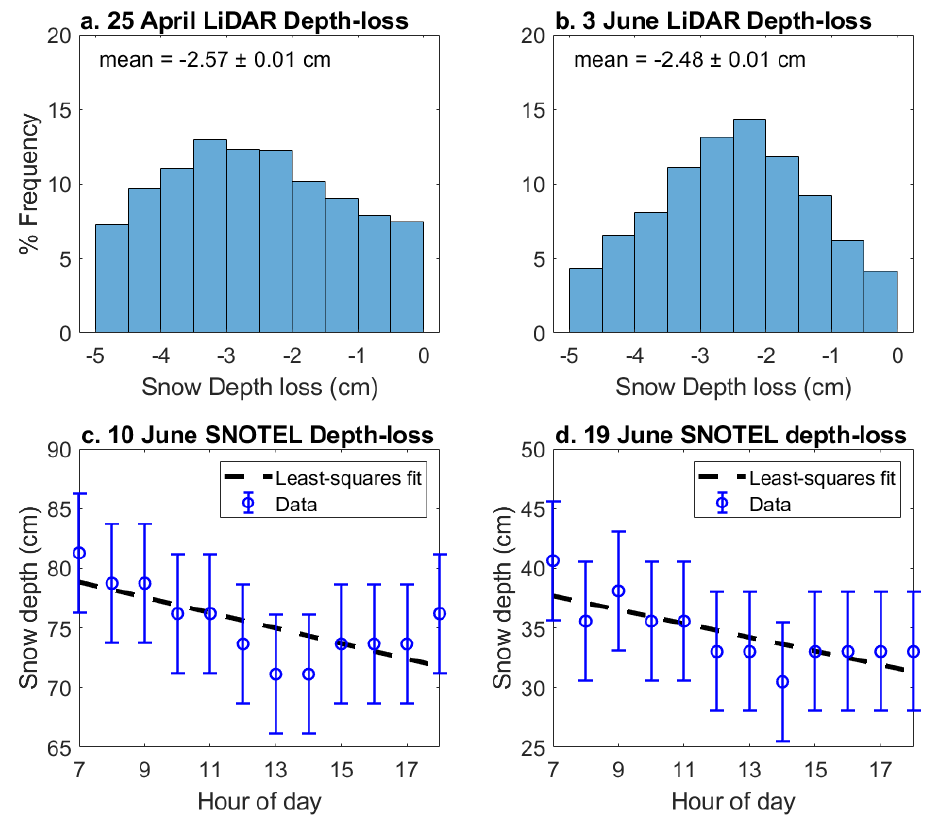
Figure 6. ( a ) Snow depth loss histogram for 25 April TLS morning (10:00–11:00 MDT) and midday (14:00–15:00 MDT) surveys. ( b ) Snow depth loss histogram for 3 June TLS morning and midday surveys. 95% confidence interval calculated using t-distribution. ( c ) 10 June least-squares regression analysis for snow depth loss plotted with SNOTEL measured depths with 5 cm uncertainty. ( d ) 19 June least-squares regression analysis for snow depth loss plotted with SNOTEL measured depths with 5 cm uncertainty. Regression performed on hourly Joe Wright SNOTEL station snow depth data between 08:00 and 18:00 MDT.